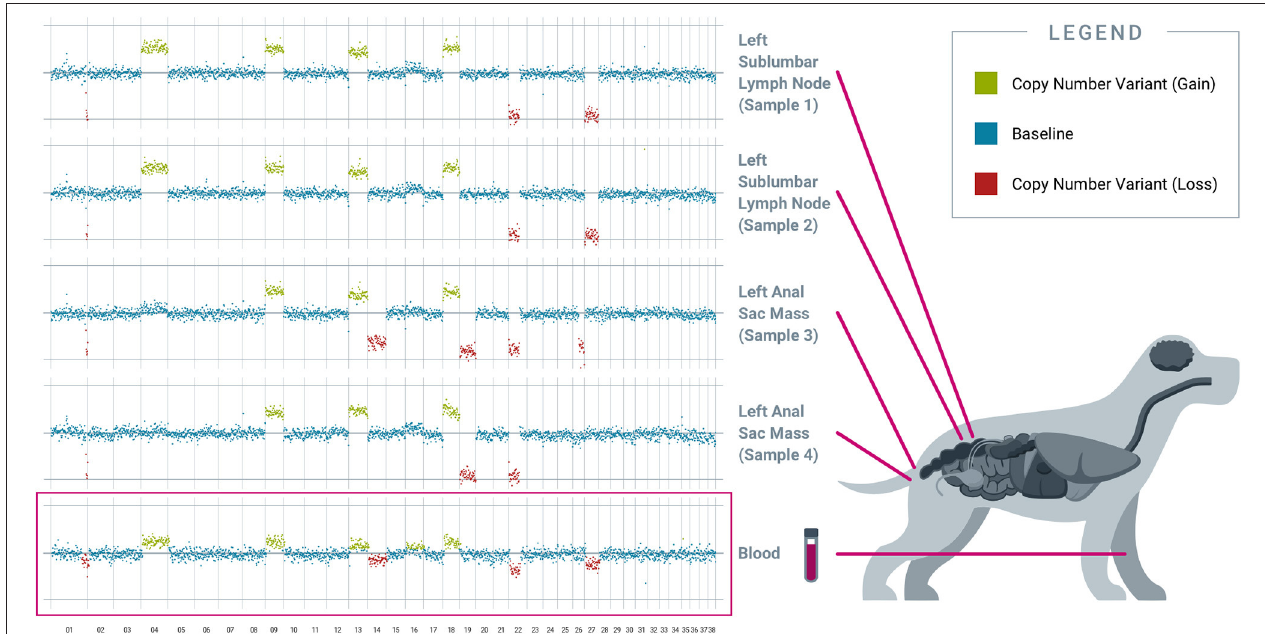
FIGURE 1 | Individual tissue samples reveal distinct somatic copy number alterations, collectively captured in the blood-derived pre-operative plasma. Results from PT04, an 11-year-old female spayed Border Collie diagnosed with apocrine gland anal sac adenocarcinoma of the left anal sac with metastasis to a left sublumbar lymph node, are shown. Four different tumor samples were collected from spatially separated locations at two sites: the left sublumbar lymph node (two samples) and the left anal sac mass (two samples). Copy number variation analysis revealed both inter-site and intra-site tumor heterogeneity. Plasma cfDNA captured shared and private alterations from both tumor sites. All chromosomes shown were interrogated for cancer-associated genomic alterations by the